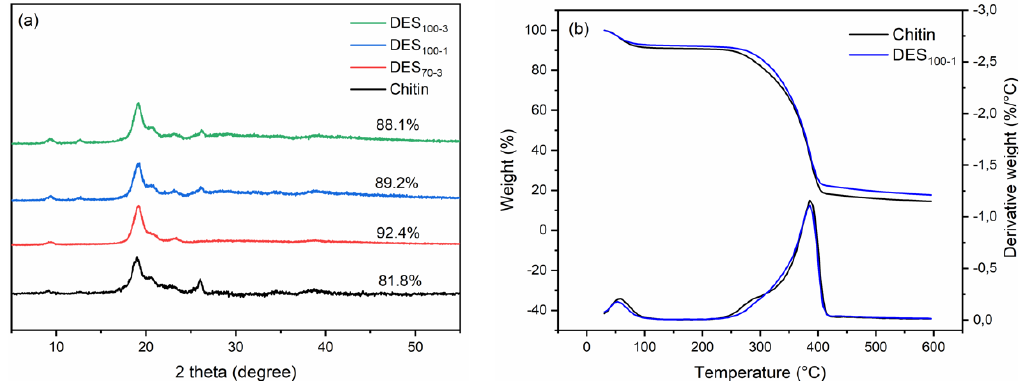
Figure 4. ( a ) XRD diffraction patterns of chitin and ChNCs prepared by DES and ( b ) TG and DTG curves of chitin and DES 100-1 ChNCs.